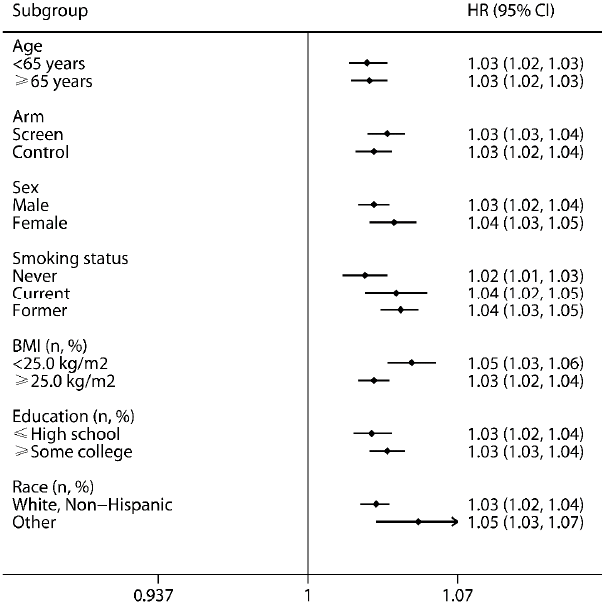
Figure 2. Subgroup analyses were performed based on various potential effect modifiers. The HRs (95% CIs) of one-unit increment in the E-DII were calculated and are shown. E-DII—Energy-ad- justed Dietary Inflammatory Index; HRs—hazard ratios; CIs—confidence intervals; BMI—body mass